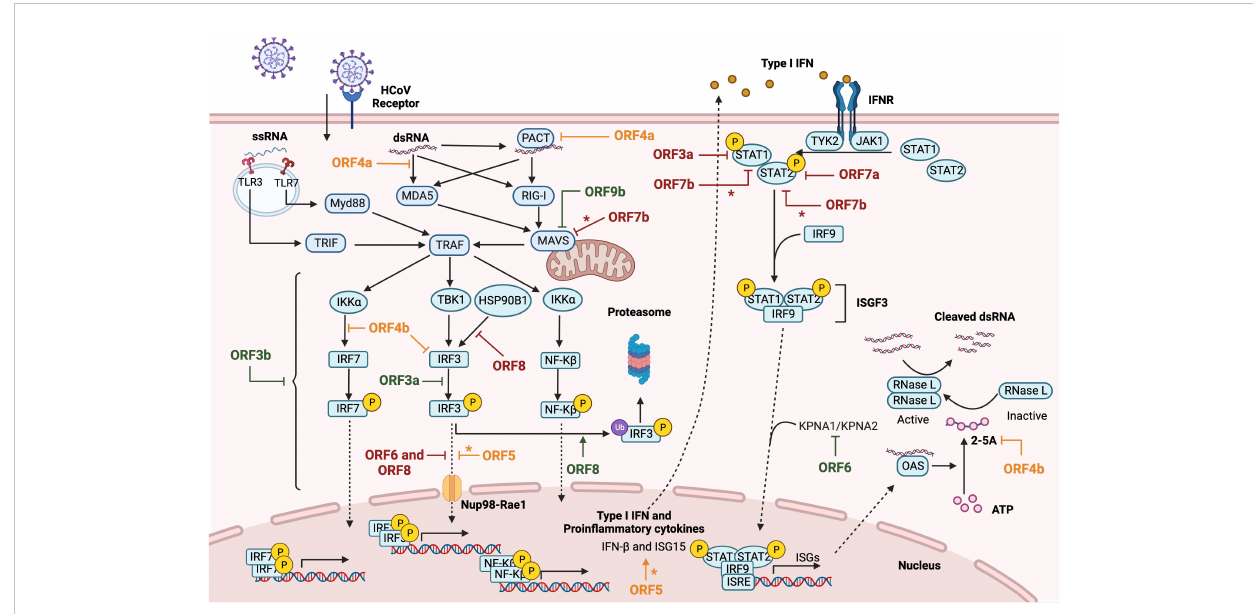
FIGURE 2 Modulation of IFN response by HCoVs accessory proteins. Diagram representing type I IFN and proin fl ammatory cytokines induction after cellular recognizing of HCoV RNA species by PRRs. After viral RNA sensing, MAVS-mediated nuclear transcription factor NF-K b and IRFs activation induce IFN and proin fl ammatory cytokines expression. The canonical autocrine or paracrine type I IFN signaling pathway triggers ISGs expression through ISGF3 complex activation. SARS-CoV accessory proteins are represented in green, MERS-CoV in orange and SARS-CoV-2 in red. The asterisk (*) indicates inconclusive results. Figure created with